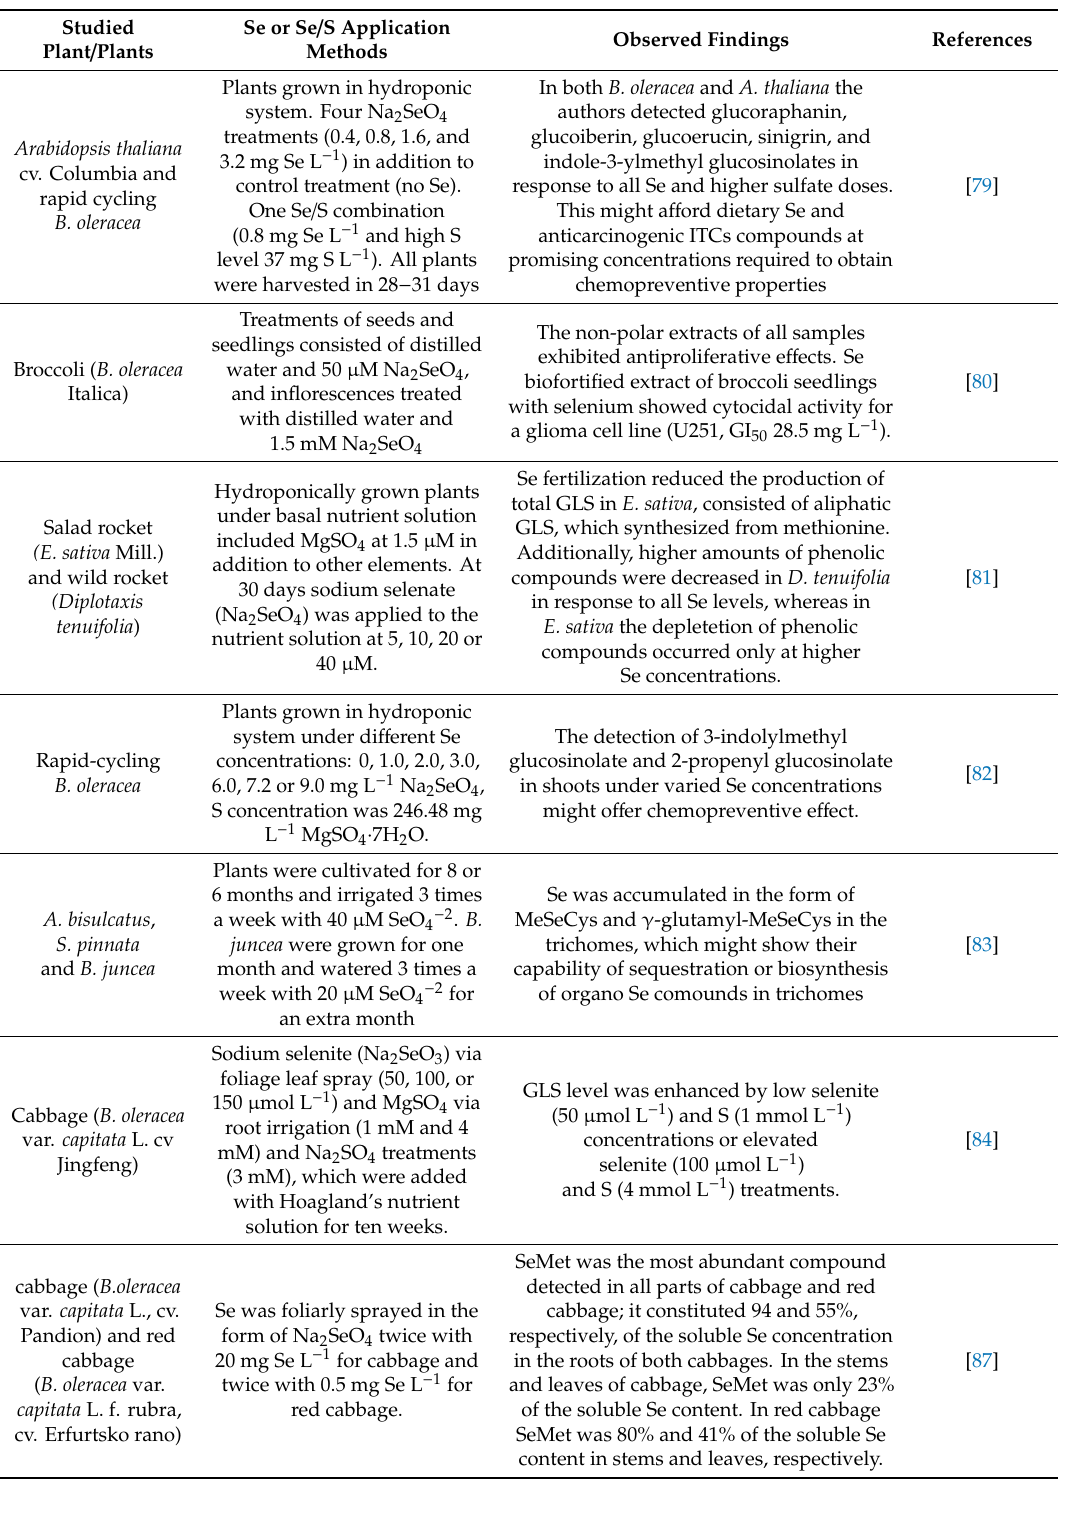
Table 1. Previous studies of Se and Se / S biofortification in brassica vegetables and their metabolites inducing chemopreventive inhibitory e ff